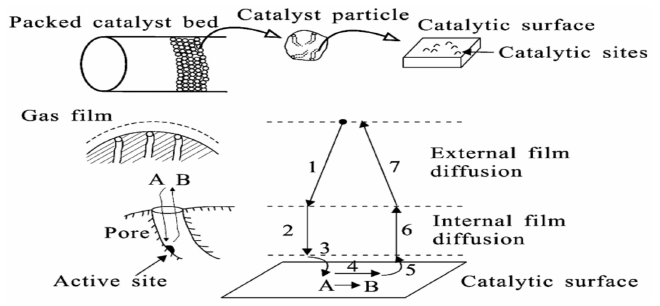
Figure 9. Schematic of the heterogeneous catalysis process on porous catalysts. Reprinted with permission from Reference [1]. Copyright (2009) Royal Society of Chemistry.